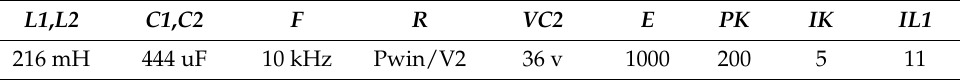
Table A1. Parameter Settings of SEPIC Configuration